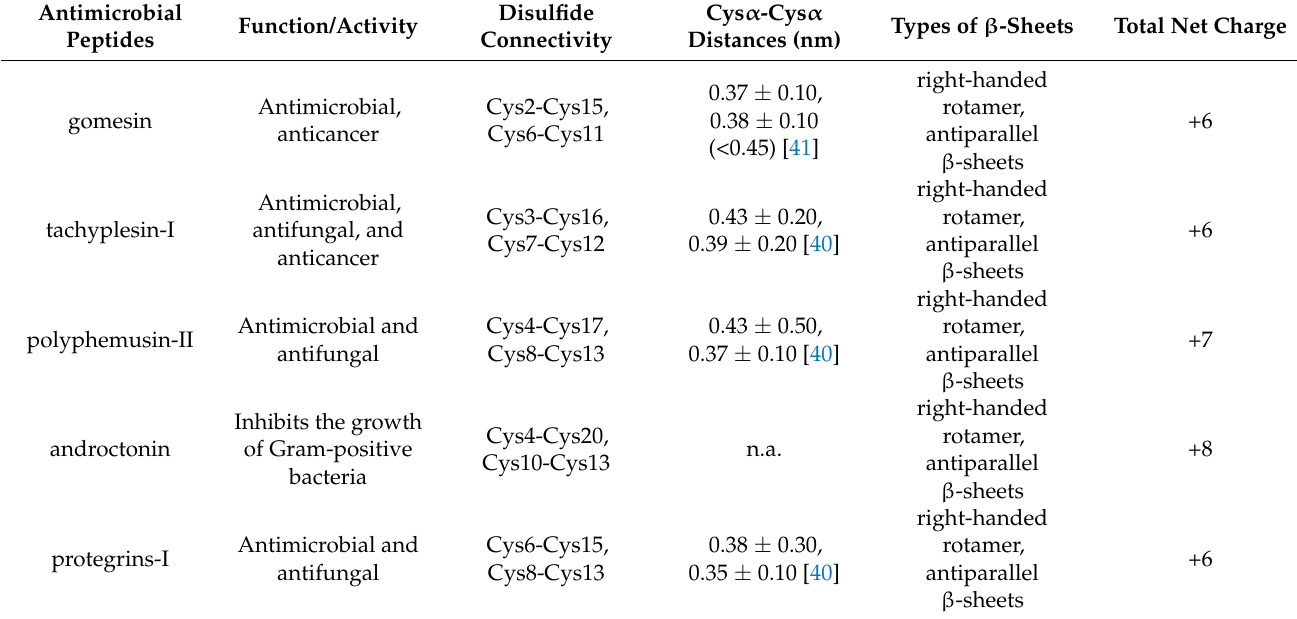
Table 1. Structural properties of antimicrobial peptides with β -hairpin-like structure.